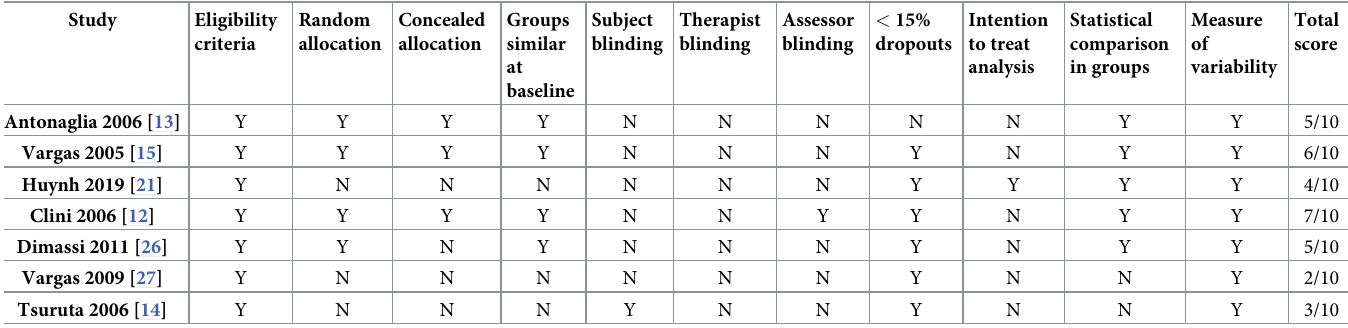
Table 2. Quality assessment using PEDro scale